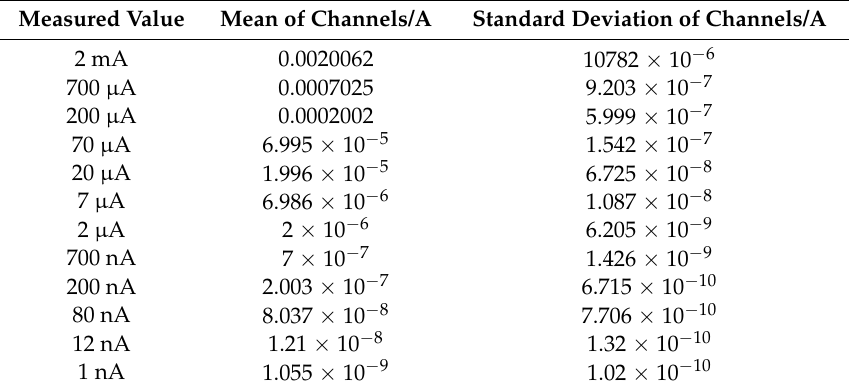
Table 1. Constant current test results of 16 channels.